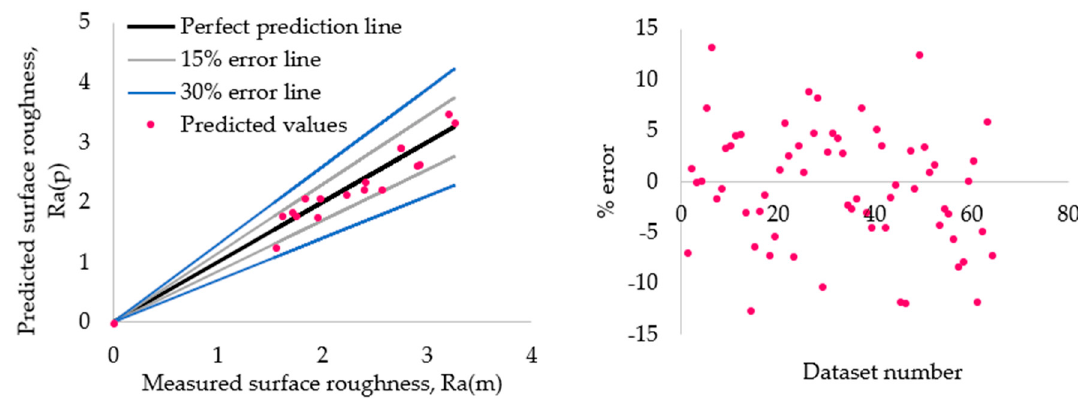
Figure 10. Scatter and error plots between the measured and simulated values of surface roughness for